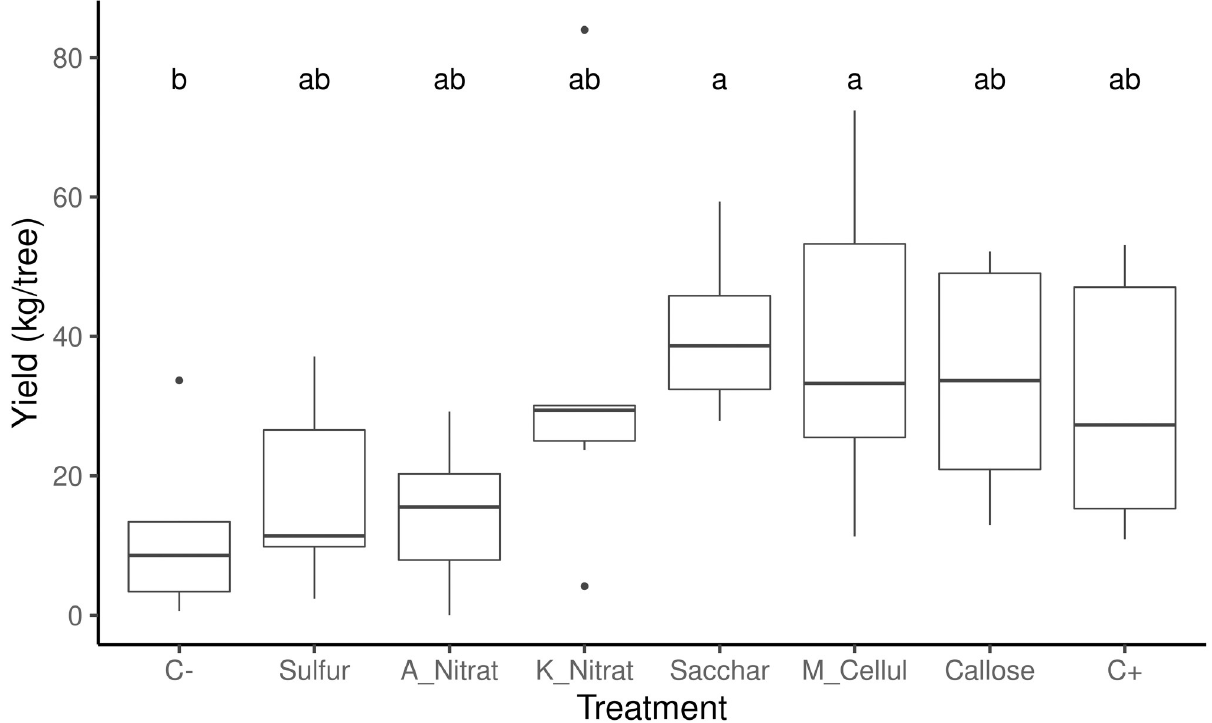
Fig 3. Box plot for the effect of treatments on yield. Different letters mean statistically significant differences in the ANOVA Tukey post hoc test (HSD) for alpha � 0.05, Df = 40, p value = 0.028. Treatments are noted as: C-, negative control; Sulfur; A_Nitrat, ammonium nitrate; K_Nitrat, potassium nitrate; Sacchar, saccharose; M_Cellul, methyl cellulose; Callose; C+, Positive control.